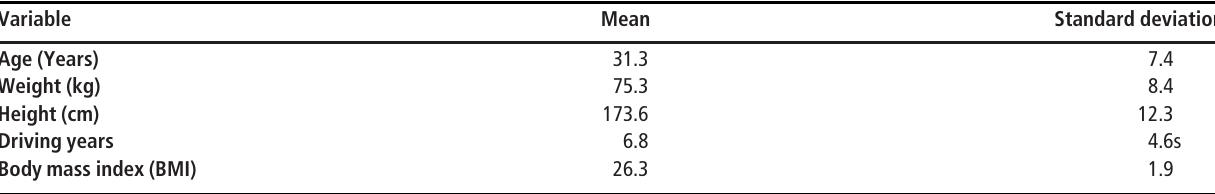
Table 7 Summary of demographic information of test drivers